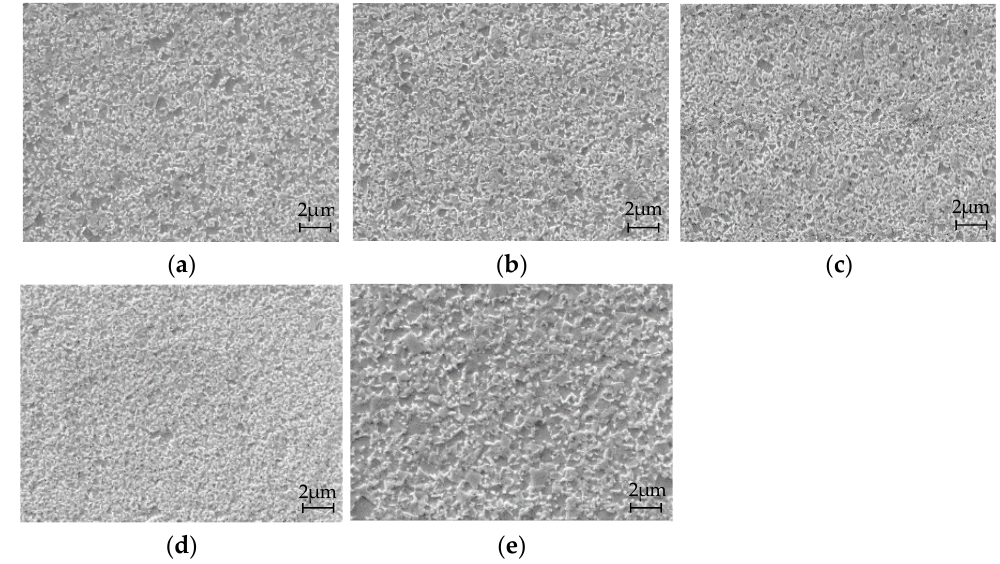
Figure 3. SEM images of the cemented carbide samples. ( a ) C0406; ( b ) C0410; ( c ) C0412; ( d ) C0206; ( e ) C0806.